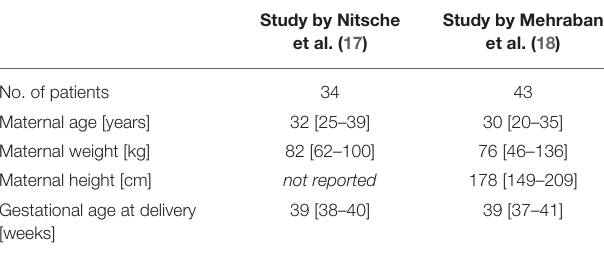
TABLE 2 | Patient